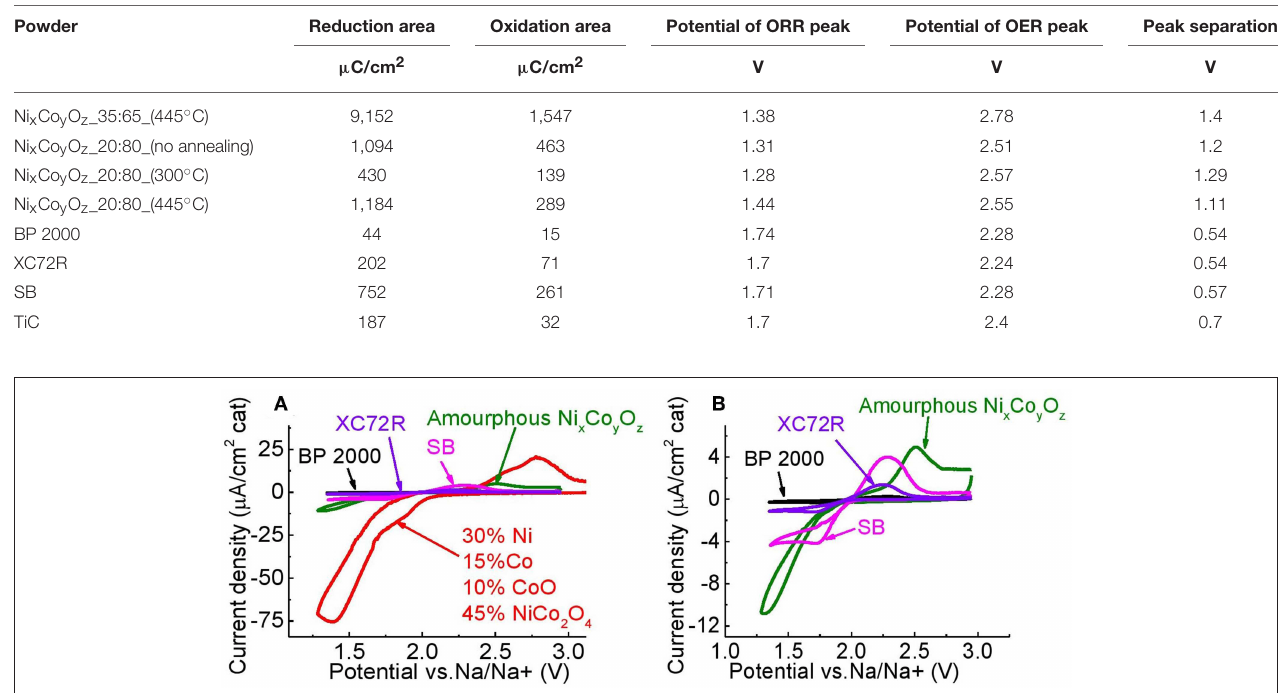
FIGURE 8 | (A) Electrocatalytic performance of Ni:Co_35:65_445 ◦ C, and Ni:Co_20:80_no annealing vs. several types of carbon, (B) magnified view of CVs of Ni:Co_20:80_no annealing vs. several types of carbon.